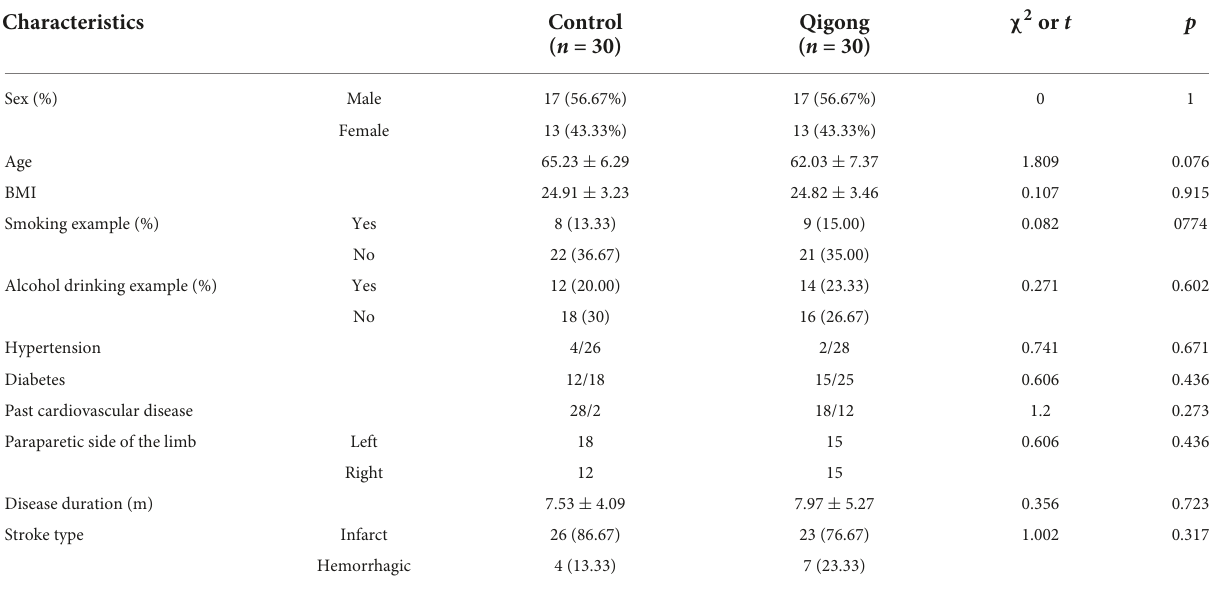
TABLE 2 General information of enrolled subjects.